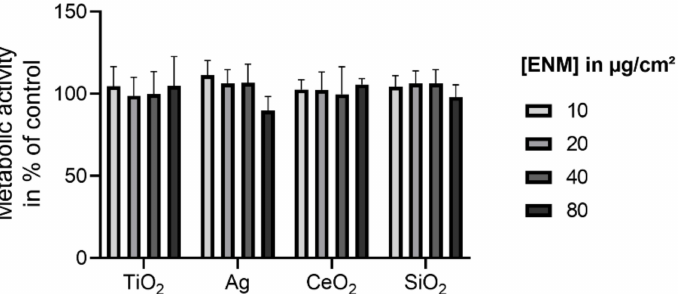
Figure 4. Relative viabilities of pre-confluent E12 cells upon exposure to TiO 2 , Ag, CeO 2 , and SiO 2 . Cells were exposed to concentrations in the range of 0–80 µ g/cm 2 for 24 h. The cell viability examined with the WST-1 assay was normalized to the negative control. The values are plotted as mean ± SD of N ≥ 3 independent experiments. An ANOVA with Dunnett’s post-hoc test was